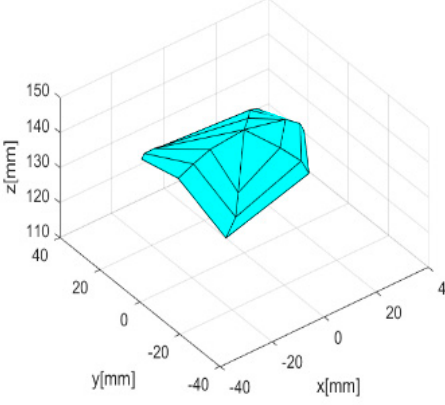
Figure 11. 3D workspace of prototype A.